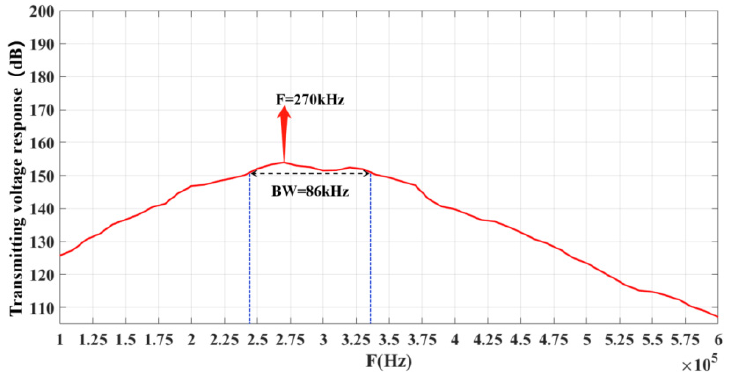
Figure 15. Response curves of transmitting voltage.